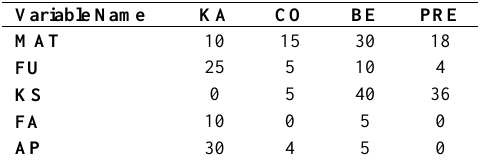
Table 2. Input–output delays (minute).